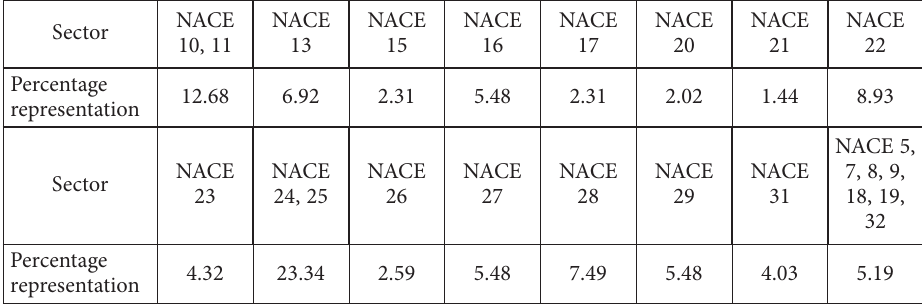
Table 1. Representation of manufacturing sectors in the research sample